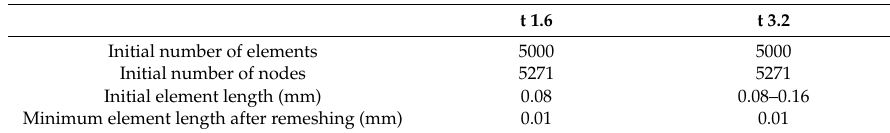
Figure 2. Axisymmetric model of the blank and punch-die set with the values of punch and die corner radii (R = 0.1) used in the finite element analysis of punching process. Table 2. Blank thickness, number of elements, number of nodes, and initial element length of the finite element analysis model for punching processes.